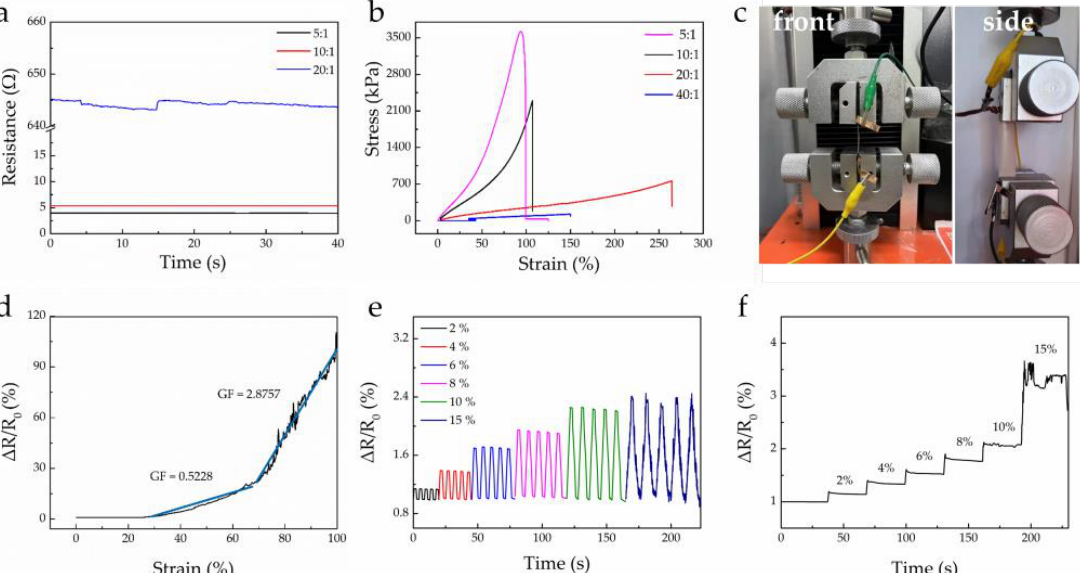
Figure 3. ( a ) Initial resistance values of AgNWs/PDMS films, and ( b ) stress–strain curves of AgNWs/PDMS films with different mass ratios of main agent and curing agent. ( c ) Digital photograph of AgNWs/PDMS film during the stretching process. ( d ) Tensile resistance variation. ( e ) The cyclic response and ( f ) the step response of AgNWs/PDMS thin-film sensor at 2%, 4%, 6%, 8%, 10%, and 15% strain.